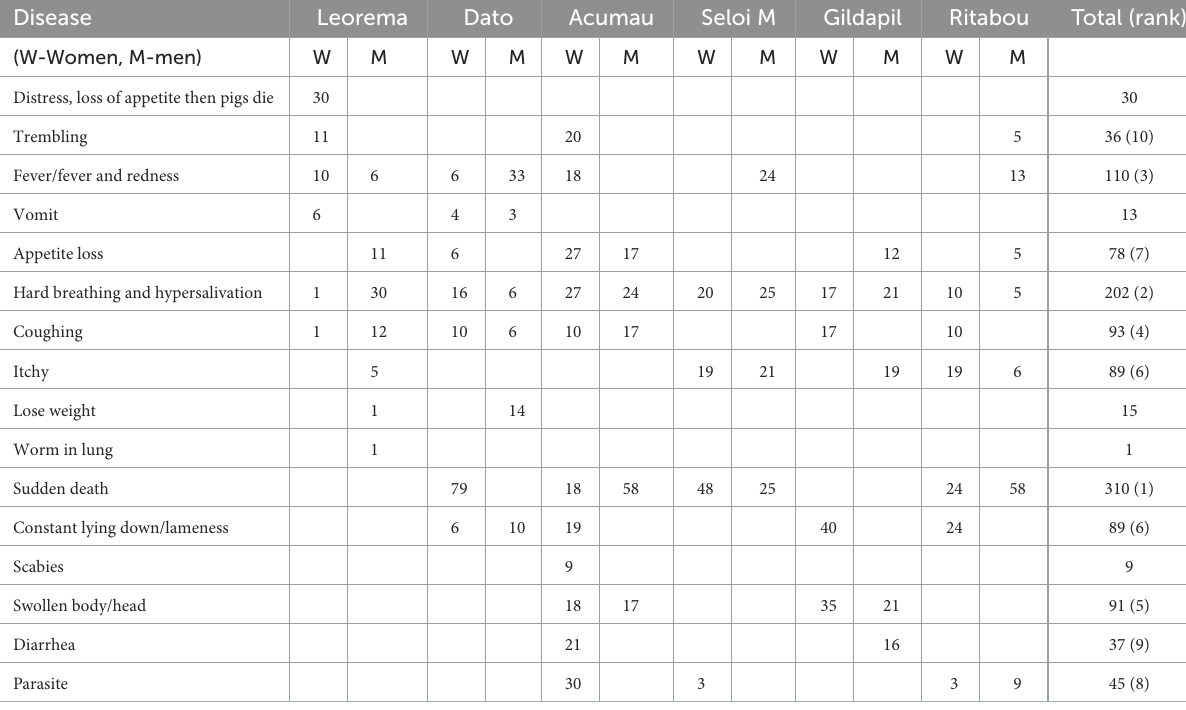
TABLE 2 Ranking of disease signs for severity by allocation of 10 pins. Disease